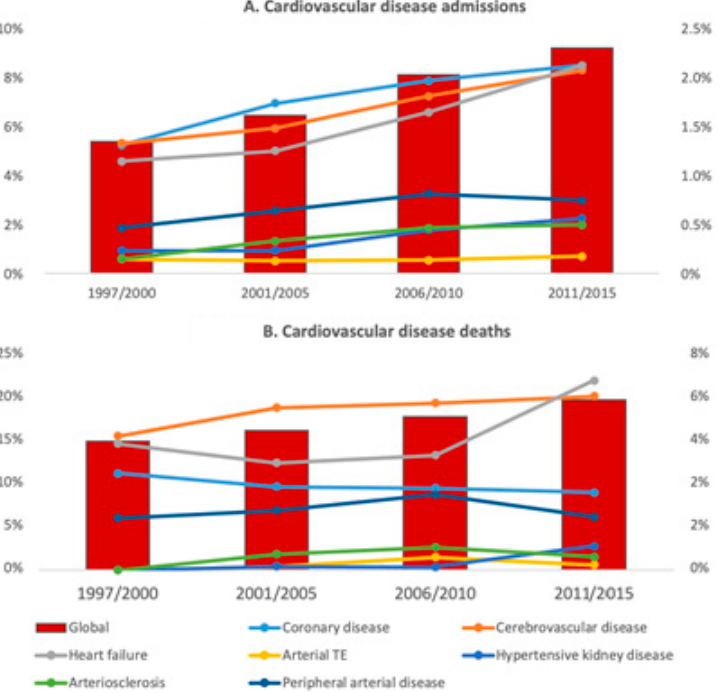
Figure 1. Cardiovascular disease admissions and deaths. The figure shows the trends in admissions ( A ) and deaths ( B ) for cardiovascular disease. Data are expressed as a percentage of total admissions and deaths for cardiovascular disease (left ordered axis) and for the subgroups that comprise cardiovascular disease (right ordered axis).